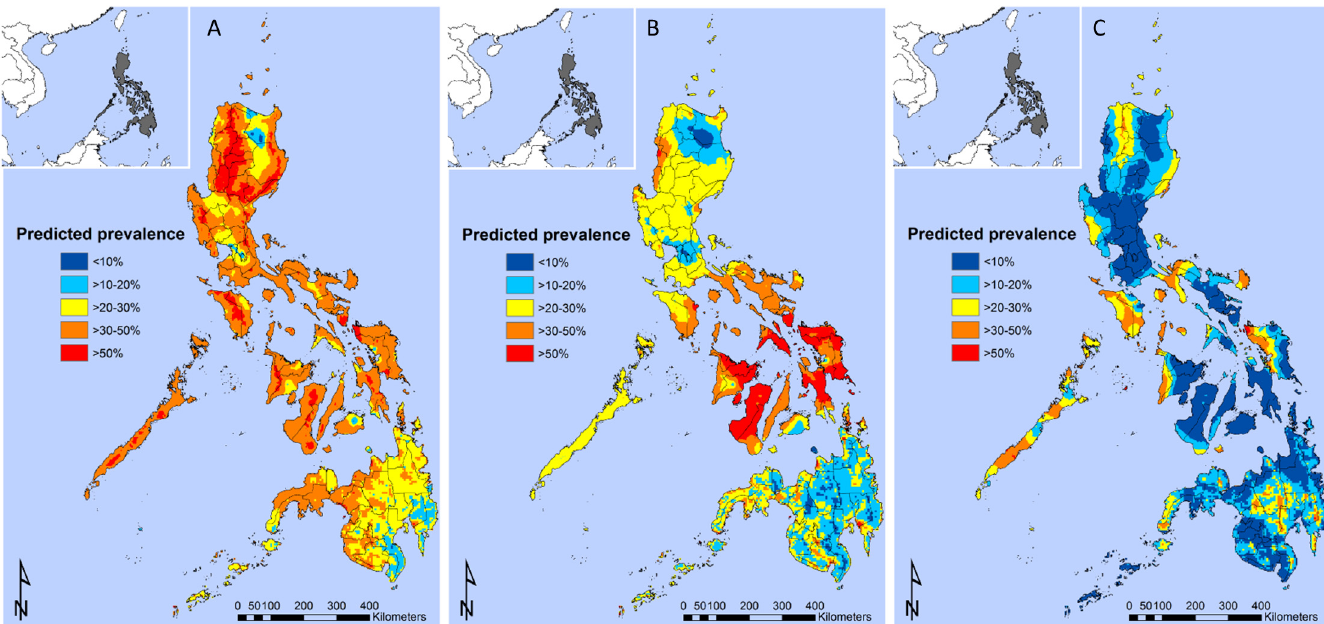
Fig 3. Predicted spatial distribution of Ascaris lumbricoides (A), Trichuris trichiura (B) and hookworm (C) for boys aged (cid:3) 20 years for the Philippines.